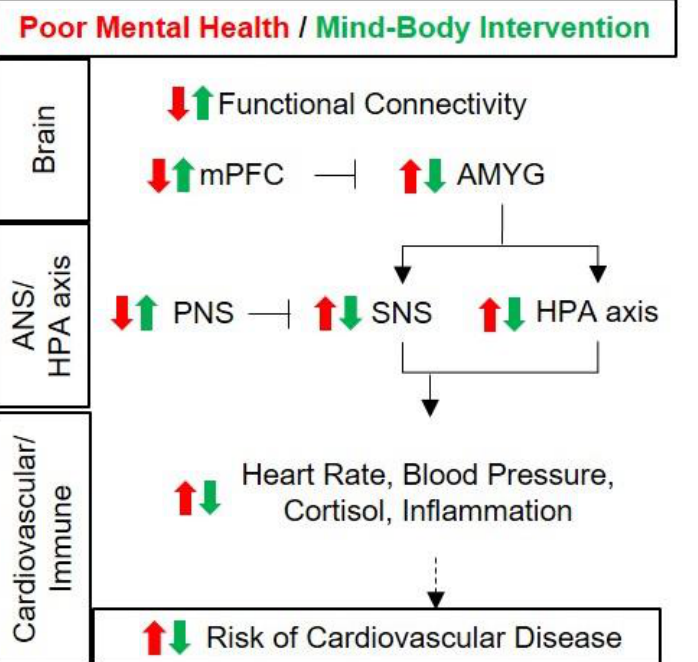
Figure 1. Potential mechanism of reduction in cardiovascular disease risks by mind–body intervention in women. Unlike in men, significant associations between amygdala activity and physiological responses have been reported specifically in women [72–75]. Poor mental health (red), such as chronic persistence of depression and stress, reduces functional connectivity between the prefrontal cortex and the amygdala, decreases activity of the medial prefrontal cortex and increases activity of the amygdala, which is controlled by the prefrontal cortex. Subsequently, the sympathetic nervous system is activated to increase the heart rate and blood pressure, while the HPA axis is activated to increase cortisol secretion, and the chronic activation of these states induces inflammation. The above states represent increased risks for cardiovascular disease. On the other hand, the application of mind–body intervention (green) helps improve mental health by reducing perceived stress and depression. The functional connectivity between the prefrontal cortex and the amygdala increases, and the activity of the medial frontal cortex also increases, thereby reducing the activity of the amygdala. Mind–body intervention activates the parasympathetic nervous system, thereby reducing sympathetic nerve activity, as well as reducing HPA axial activity as stress decreases. As a result, heart rate, blood pressure and cortisol secretion are reduced and inflammatory conditions are reduced. These states mean a reduction in cardiovascular disease risk. AMYG, amygdala; mPFC, medial prefrontal cortex; SNS, sympathetic nervous system; HPA, hypothala-